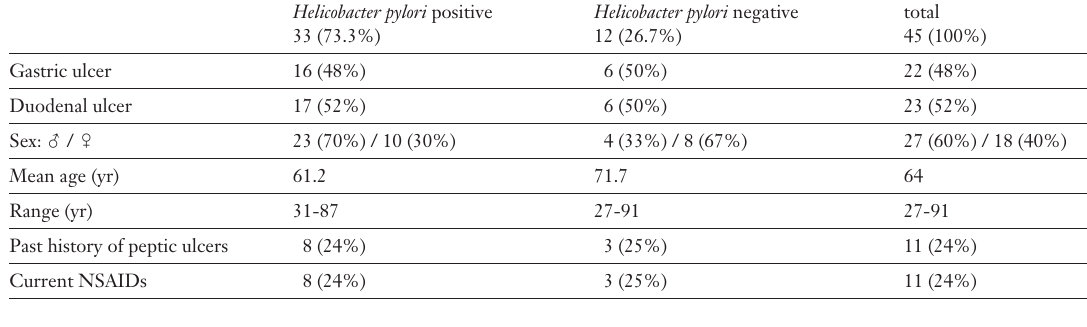
Age, sex and compli- cations in relation to operative approach and hospital stay (n =